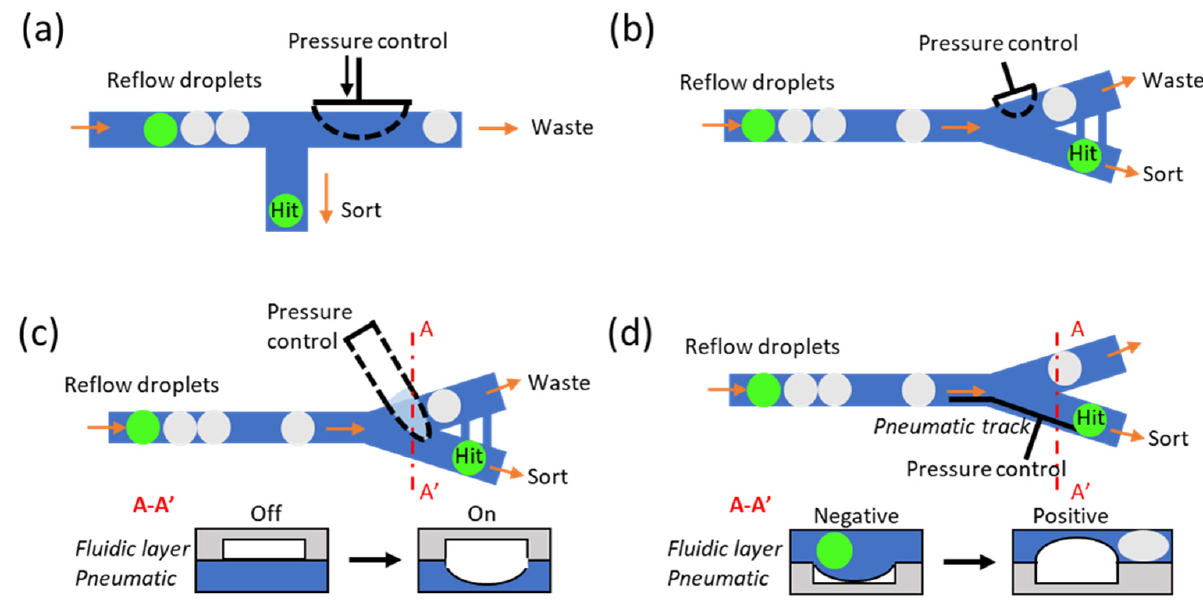
Figure 4. Variety of different versions of pneumatic based droplet sorters. ( a ) Very first pneumatic sorter that uses a side channel to block the main downstream channel to deflect hit droplets into the bottom channel; ( b ) sorter with a valve that directly points towards the tip of the bifurcation structure and creates subtle disturbance to deflect hit droplets to the opposite channel; ( c ) bilayer structure that deforms the ceiling of the fluidic channel to achieve physical blockage, and A–A’ shows the cross sectional structure before/after the pressure is applied; ( d ) pneumatic rail design (black line) that can achieve guiding (negative pressure) and blockage (positive pressure) functions, and A–A’ shows the cross sectional structure before/after the pressure is applied.